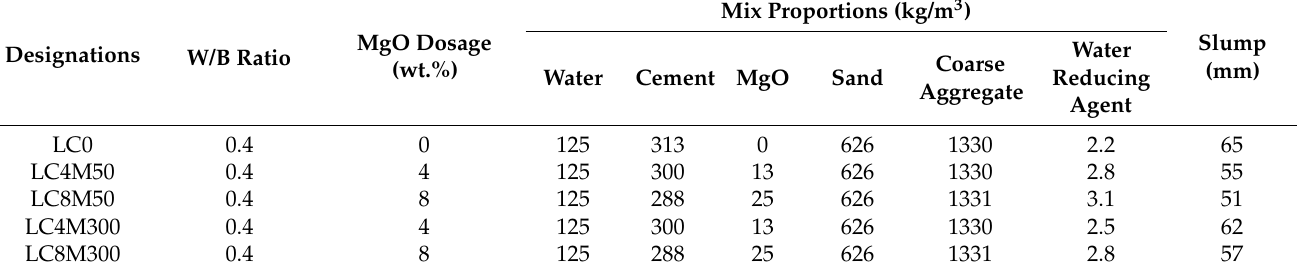
Table 3. Mixture proportion of